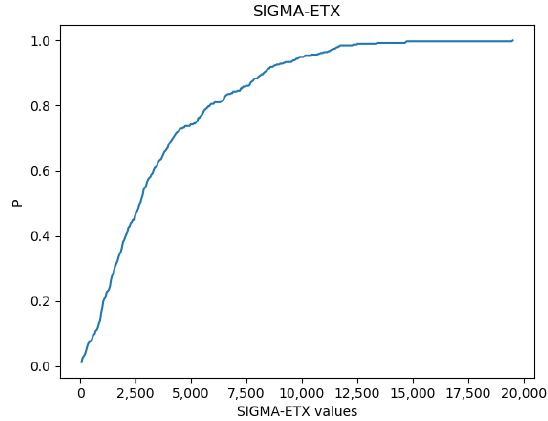
Figure 3. SIGMA-ETX CDF.